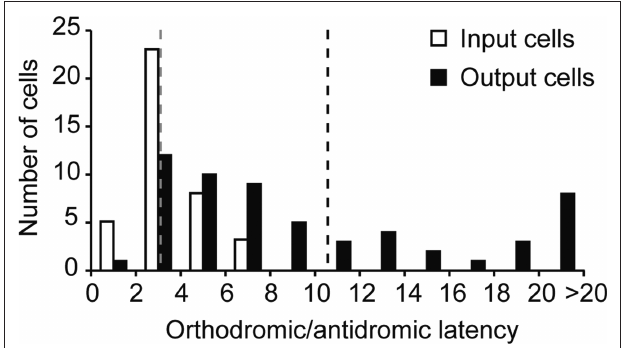
FIGURE 1 | Distribution of orthodromic and antidromic activation latencies for input and output neurons. Orthodromic activation latencies for input (geniculocortical-recipient) neurons are indicated with open bars, mean orthodromic latency illustrated by dashed grey line. Antidromic activation latencies for output (corticogeniculate) neurons are indicated with black bars, mean antidromic latency illustrated by dashed black line.